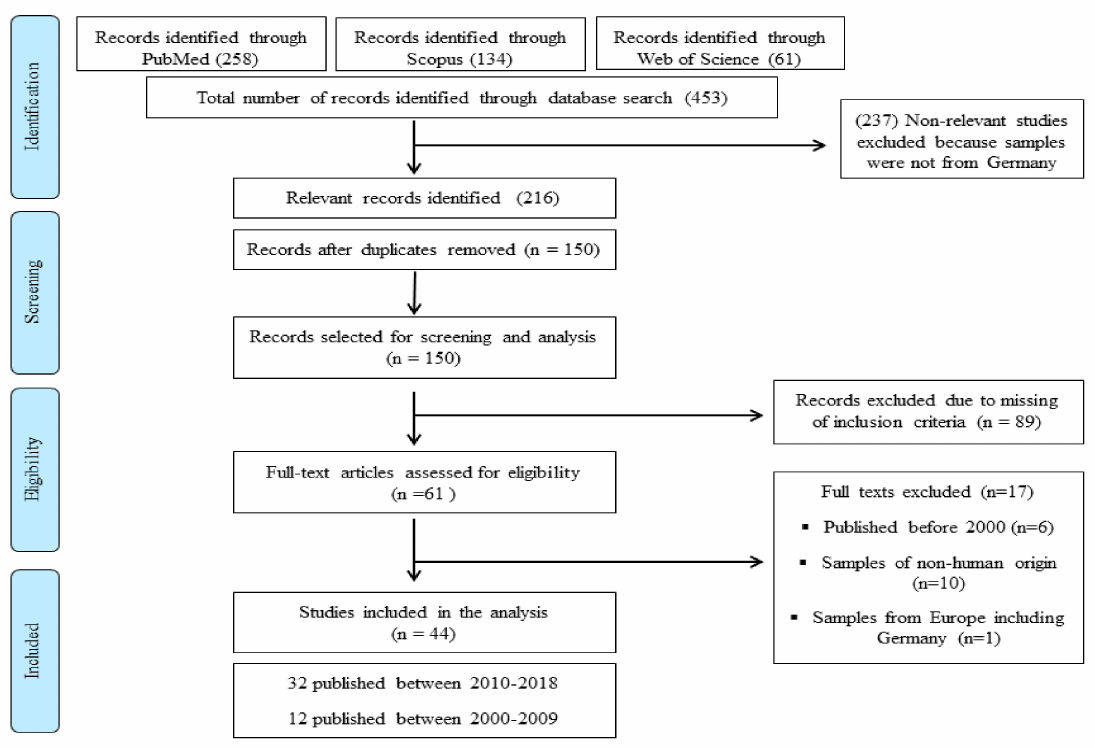
Figure 1. Systematic review flowchart: Acinetobacter baumannii in Germany, the flow diagram indicates the inclusion and exclusion of publications at each stage of the systematic review